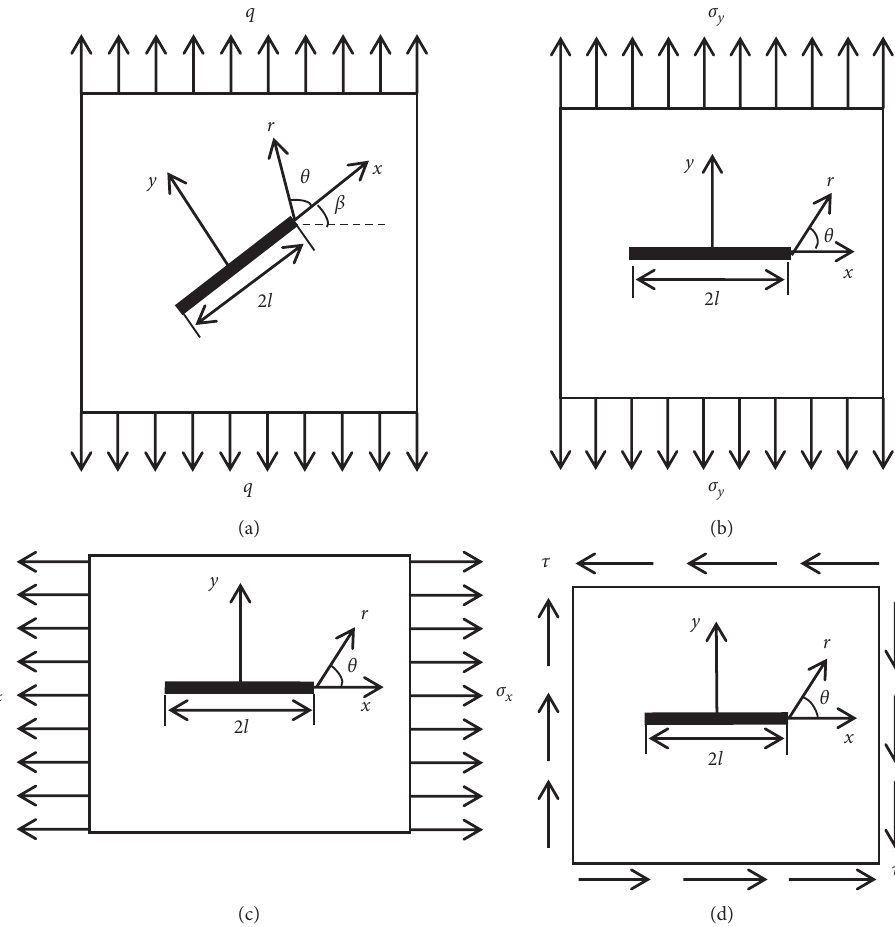
Figure 5: Calculation model of the crack propagation criterion: (a) initial tension problem with cracks; (b) a 2-D plane element with a mode-I (open) crack in the centre with uniaxial tension in the y -direction; (c) a 2-D plane element with mode-I crack in the centre with uniaxial tension in the x -direction; and (d) a 2-D plane element containing a mode-II (slit) crack subjected to uniform